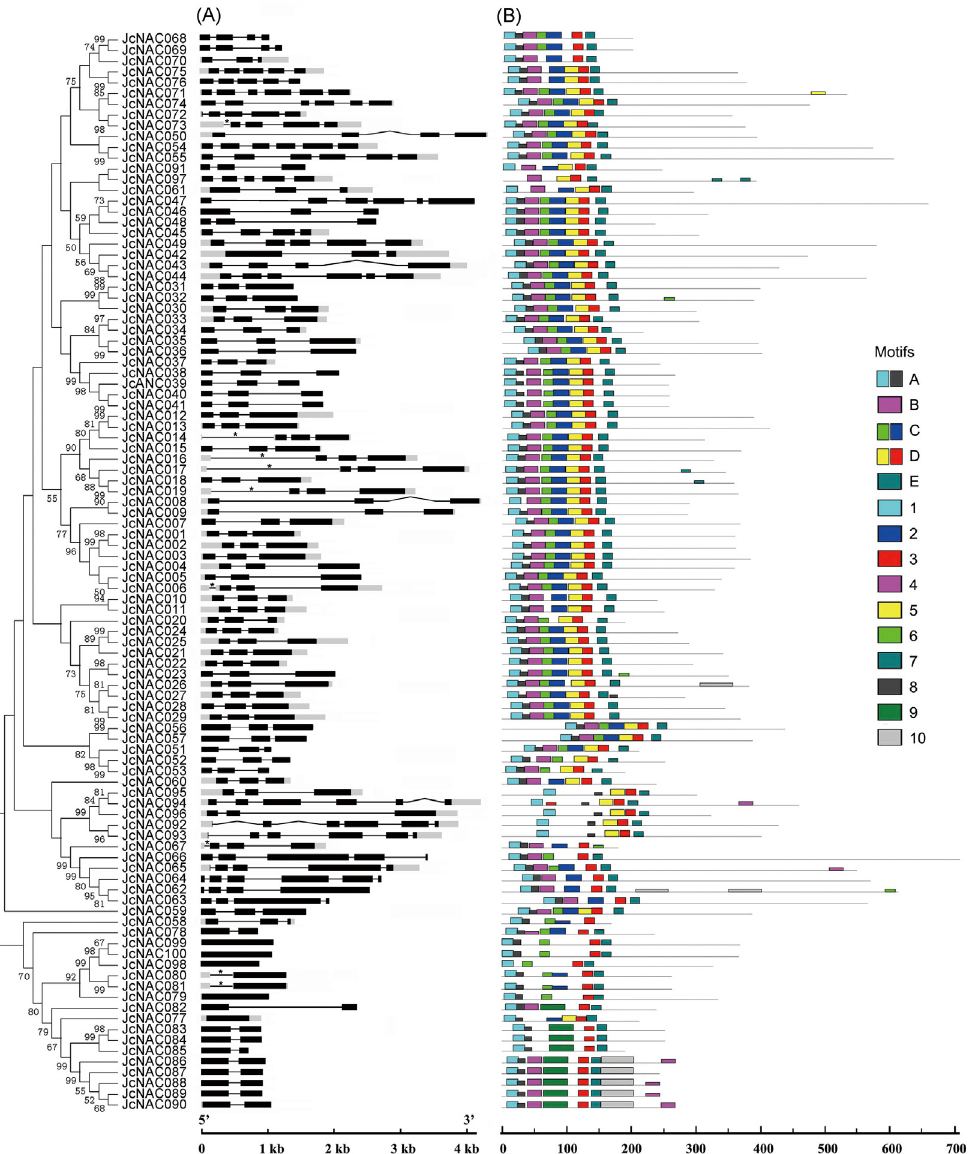
Fig 1. Gene structure and motif locations of JcNAC genes. (A), Exon/intron arrangements of JcNAC genes. Exons and introns are represented by black boxes (open reading frame in black, untranslated region (UTR) in gray), and black lines, respectively, and their sizes are indicated by the scale at the bottom. * , intron in the UTR. (B), Schematic representation of conserved motifs in the JcNAC proteins predicted by MEME. Each motif is represented by a number in the colored box. The black lines represent non-conserved sequences. The relationships between motifs and conserved domains (A-E) are shown on the right. The lengths of JcNAC proteins can be estimated from the scale at the